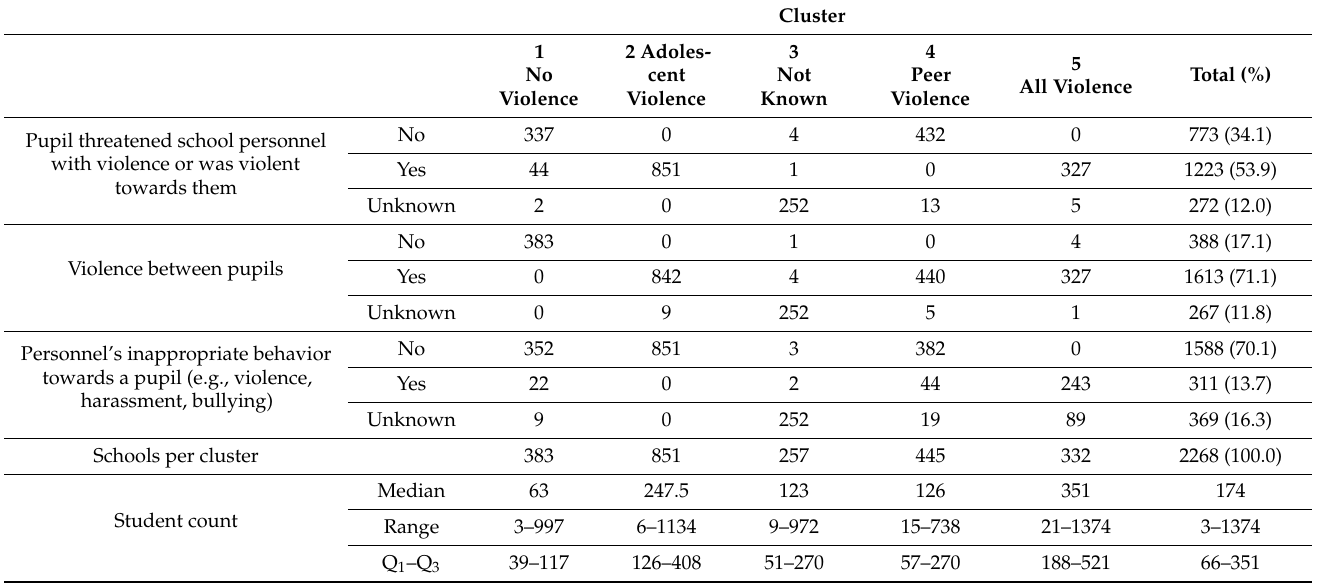
Table 3. Number of schools regarding clusters and school violence ( n = 2268).